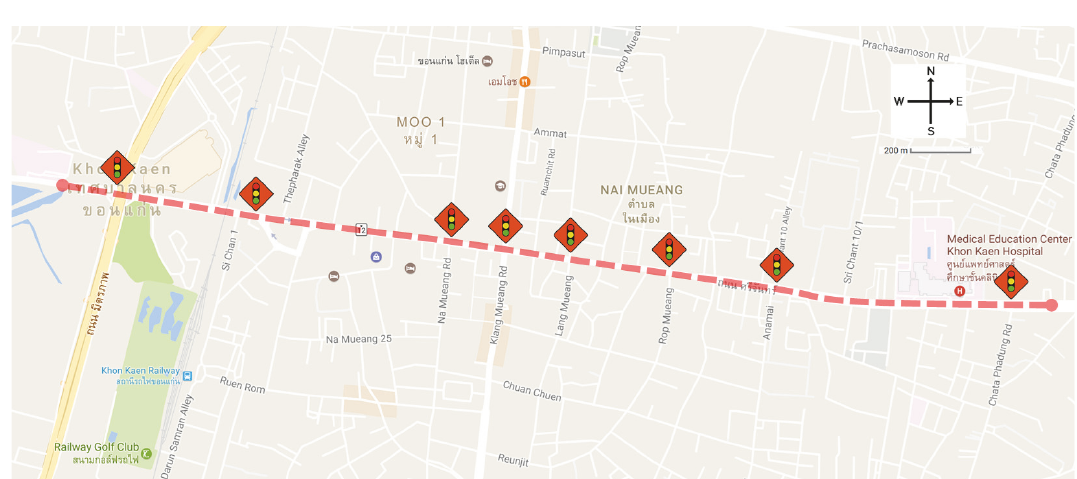
Figure 3: Selected study section located with 8 closing signalized